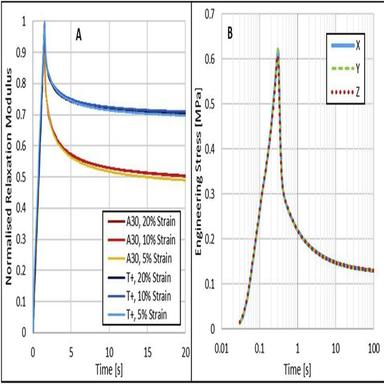
DMA loss tangent and storage modulus (E') results temperatures relevant to glass transition of A30 (left) and T+ (right) samples printed in different orientations.